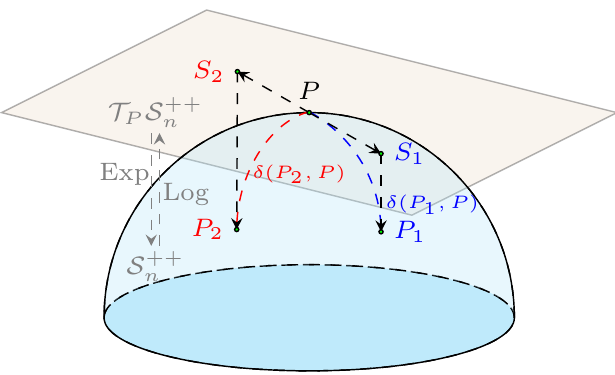
++ n (see [1,4] for S